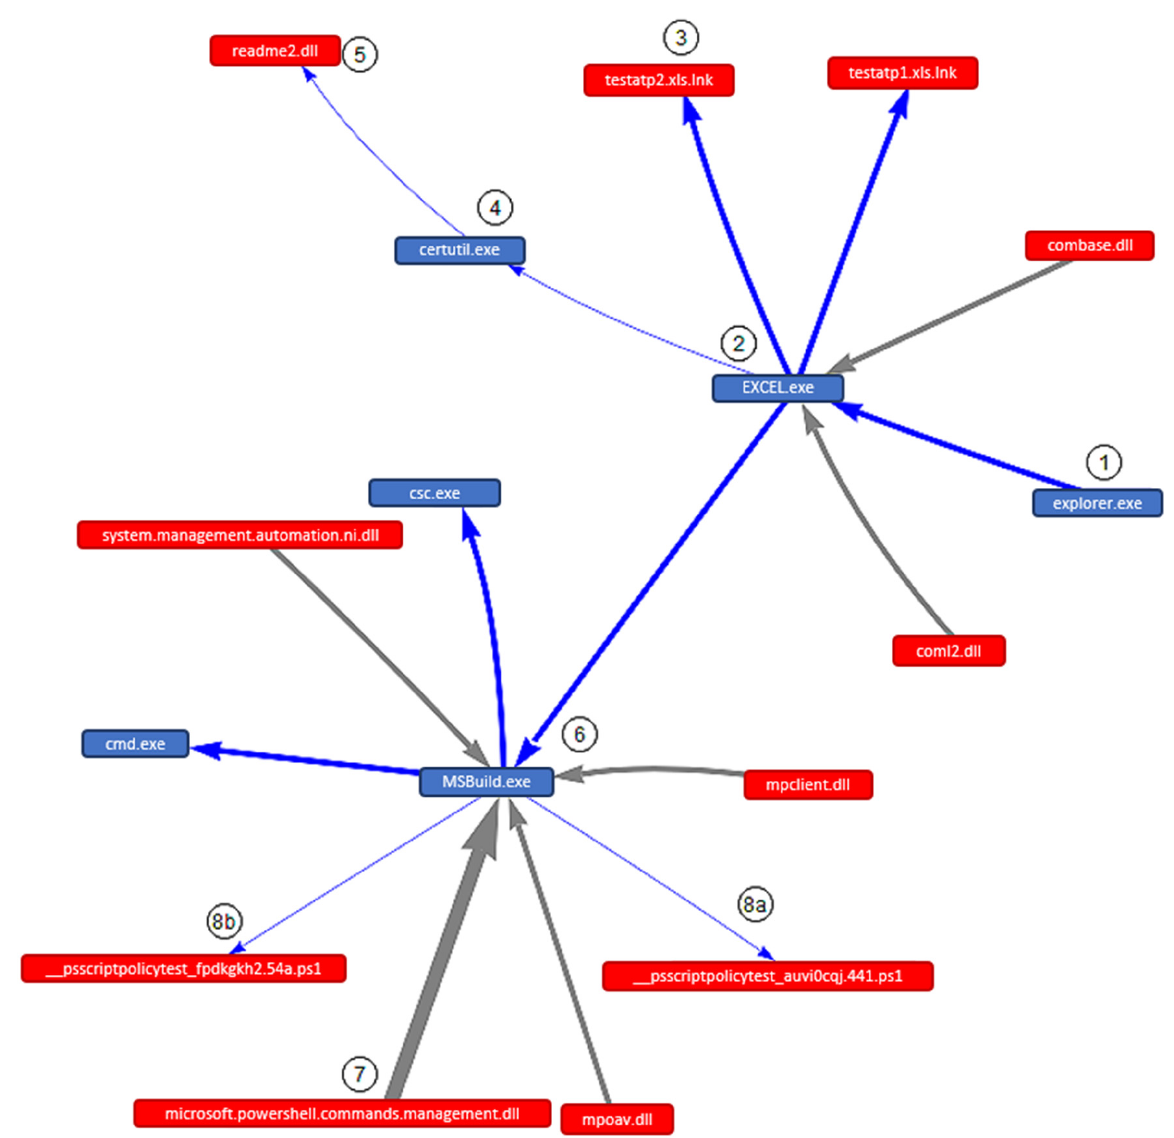
Figure 5. Result of Excel document execution with CertUtil.exe and MSBuild.exe.